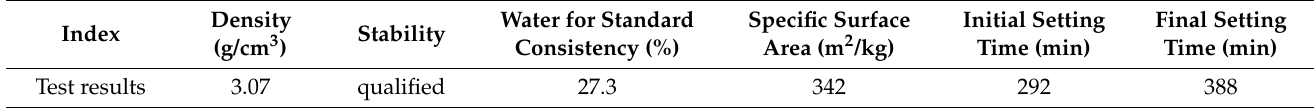
Table 2. Technical properties of cement.